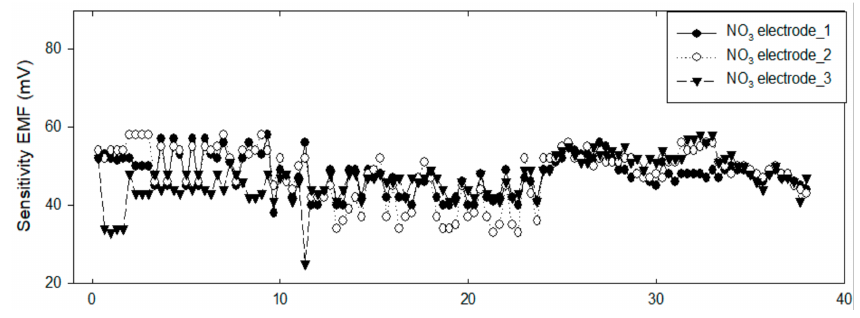
Figure 7. Sensitivity variation of three NO 3 − electrodes during laboratory test.